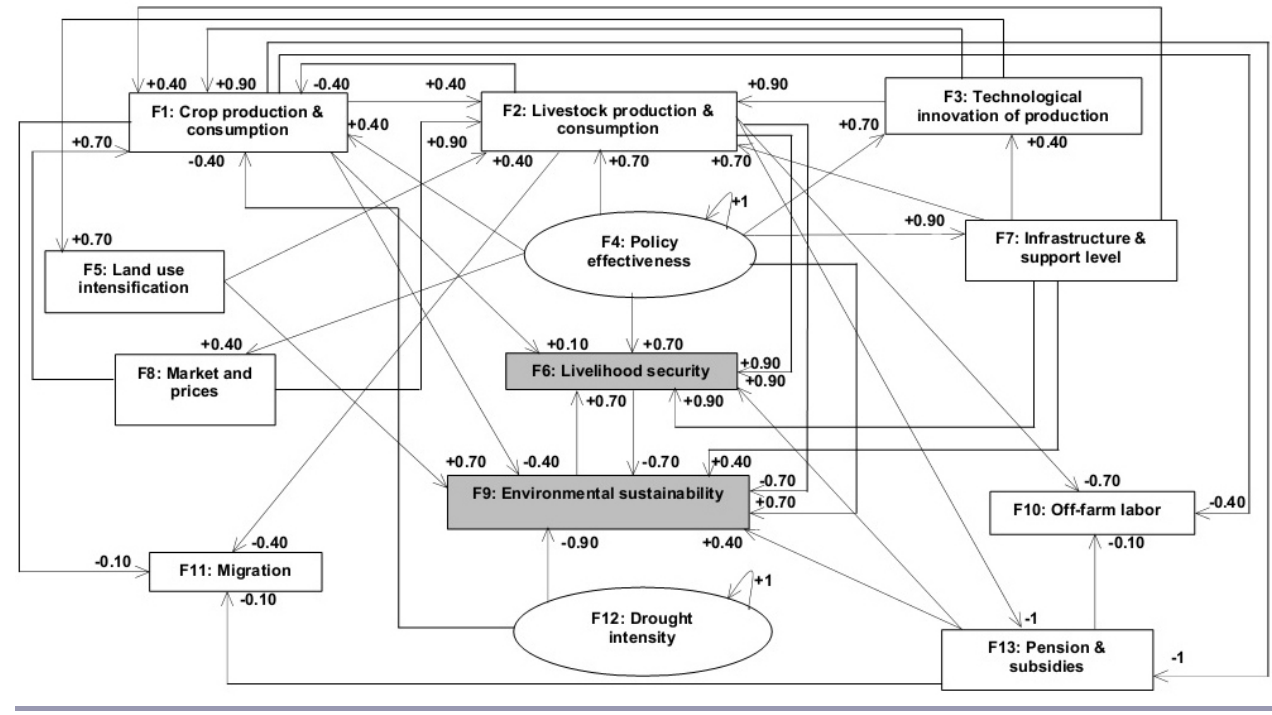
Fig. 6 . Postprocessed fuzzy cognitive map resulting from the off-farm workshop. Grey boxes are the target factors of the analysis, white boxes are the general factors, and white circles are the drivers of the system. Numbers given are the weights between factors, indicating positive and negative relationships.